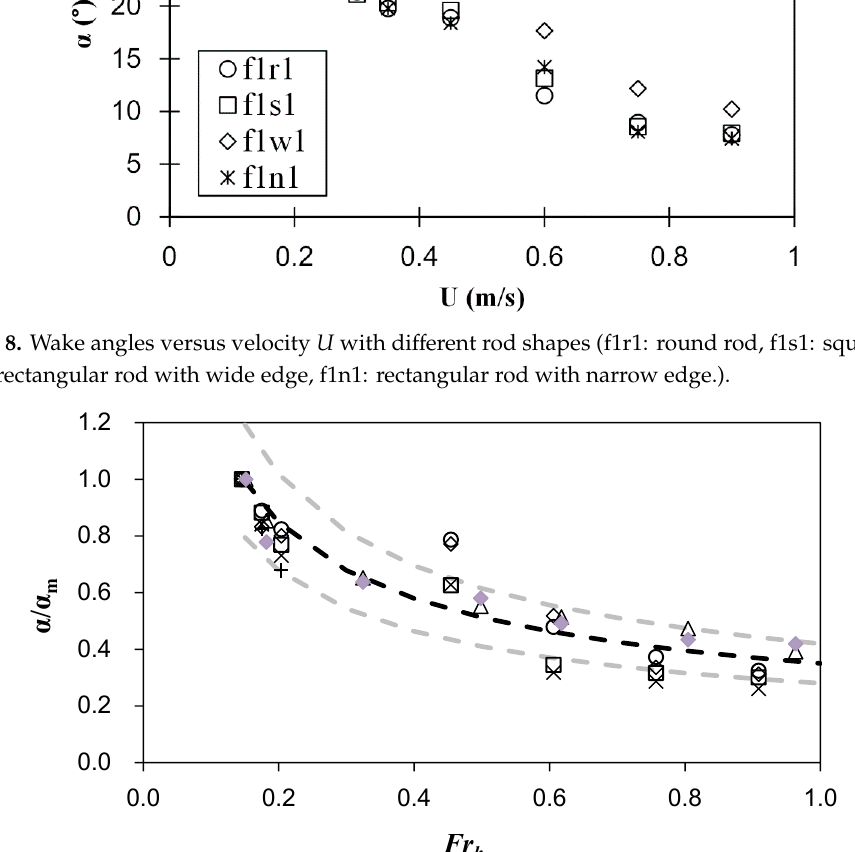
Figure 9. Normalized wake angles versus Froude number Fr (f1xx and f2xx denote the results in 0.6-m and 1.5-m wide flumes, respectively.).